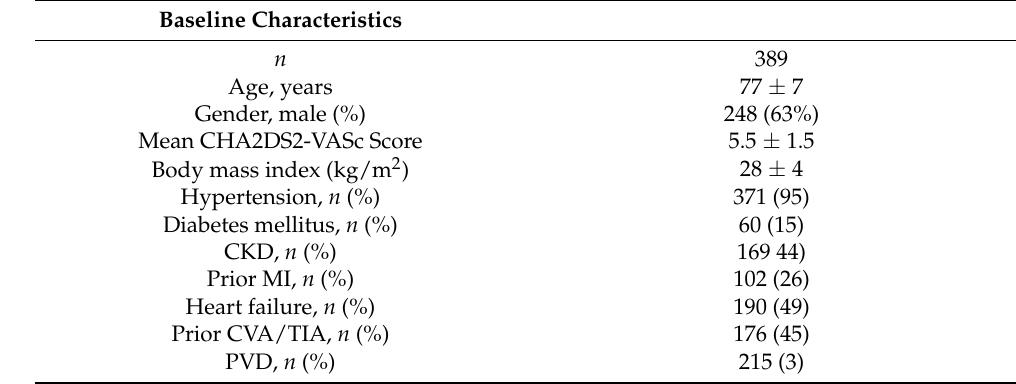
Table 1. Baseline characteristics of study participants.